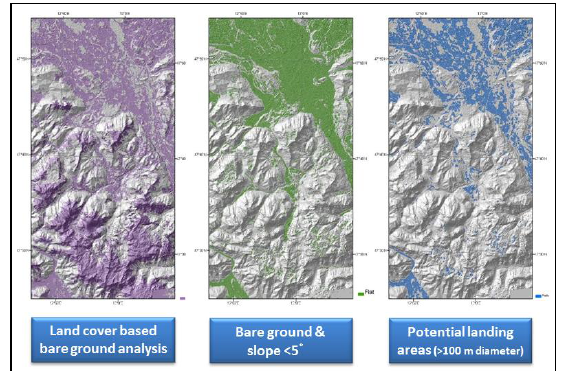
Figure 4. WorldDEM validation approach